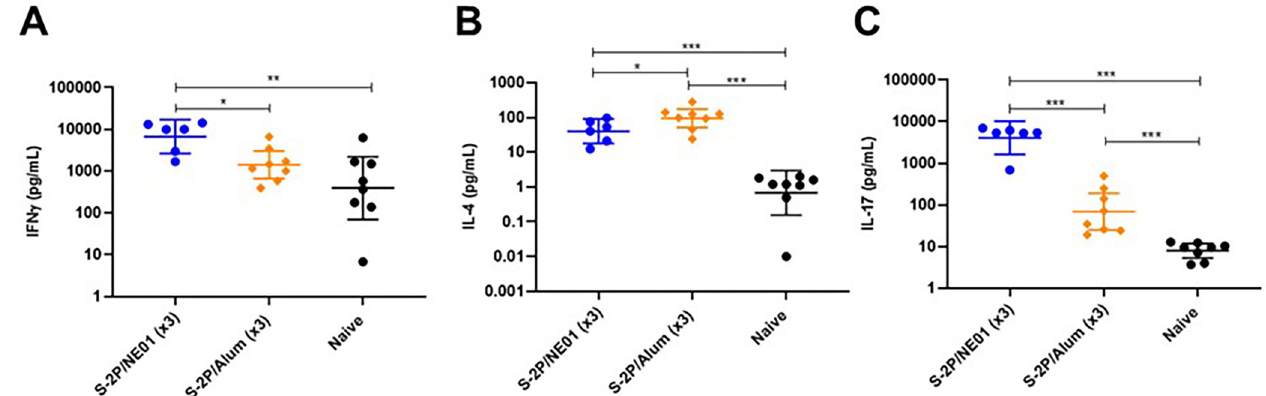
Fig 3. S-2P/NE01 immunization promotes Th1/Th17 cytokines in lungs. Release of IFN γ (A), IL-4 (B), and IL-17 (C) cytokines from S-2P stimulated single cell suspension of lungs. Data are presented as the geometric mean with a 95% confidence interval and statistical analysis was calculated between groups using Mann-Whitney nonparametric test for unpaired data, � p < 0 . 05 , �� p < 0 . 01 , ��� p < 0 . 001 .